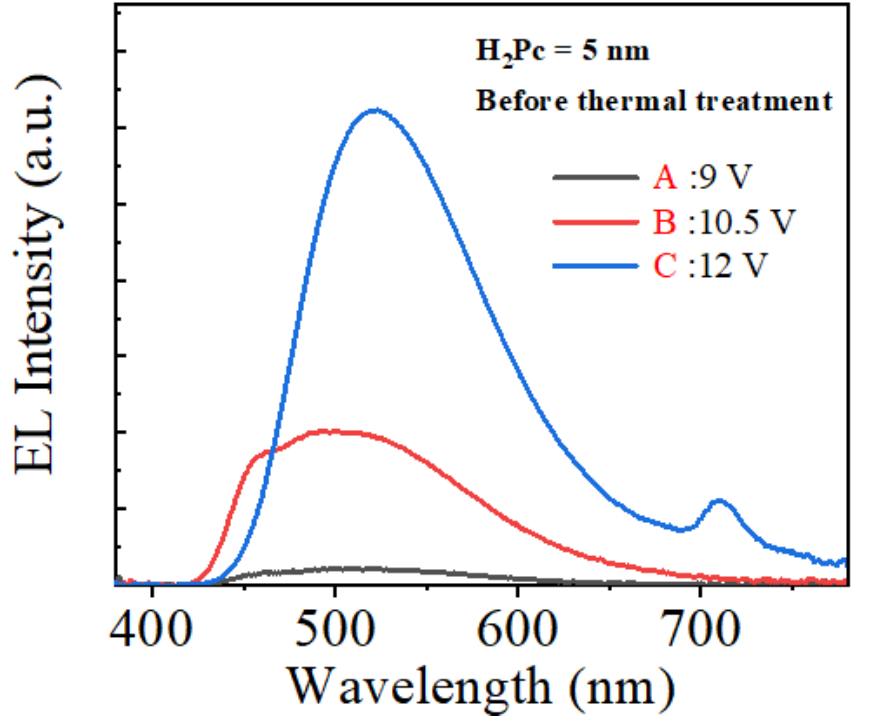
Figure 4. Electroluminescent (EL) spectra of the CTOLED before thermal treatment at the